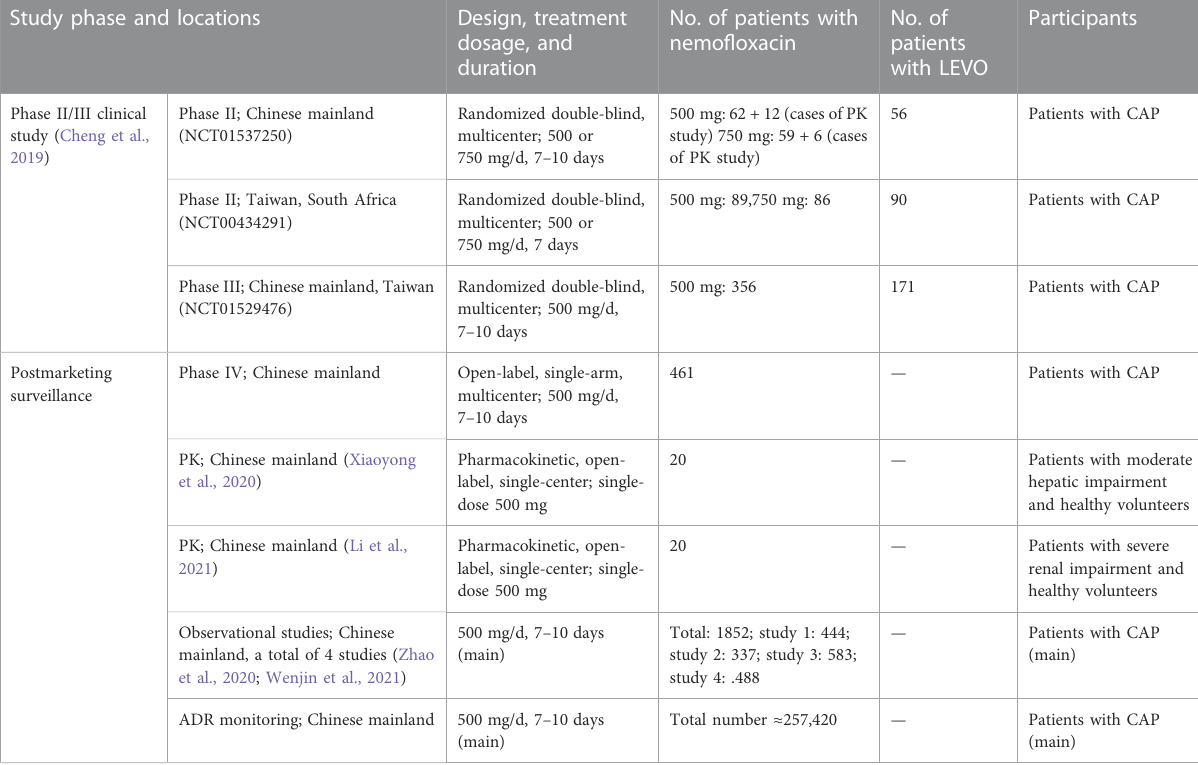
TABLE 1 Overview of clinical studies and postmarketing surveillance. Study phase and locations